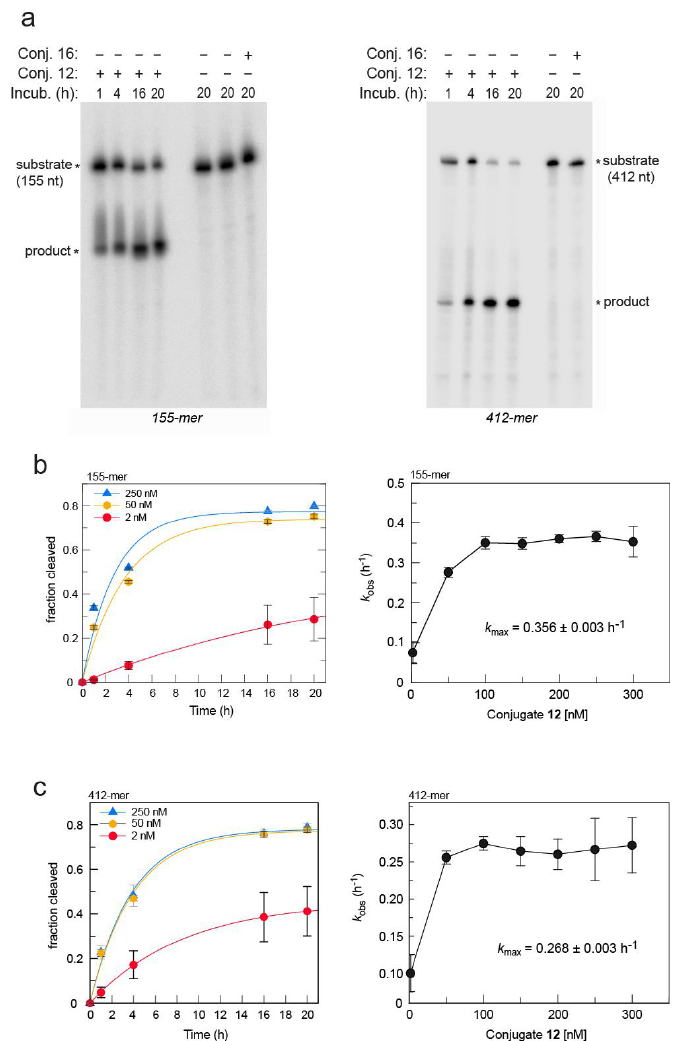
Figure 4. ( a ) Example gel images showing the time courses of cleavage of the RNA 155-mer 14 (left) and 412-mer 15 (right) by conjugate 12 at 37 °C. The 5′- 32 P-labeled 155-mer 14 and 412-mer 15 (~24 nM) were incubated with 300 nM (155-mer) and 200 nM (412-mer) of conjugate 12 for the indicated time periods. As a control, the RNA was incubated without conjugate or with the noncomplementary control conjugate 16 (cleaver-linker-5’-ctCcTgAcAaGgTat-3’; small letters: DNA; capital letters: LNA) for 20 h. ( b ) Examples of time courses (left image) of cleavage of the 155-mer 14 at three different concentrations of conjugate 12 , based on experiments, as shown in panel ( a ). Graph on the right: Plot of observed cleavage rate constant ( k obs ) as a function of conjugate 12 concentration (error bars: Standard deviation of the mean). Data points were connected by lines (no curve fitting), and the mean value of the k obs values obtained at 100 to 300 nM of conjugate 12 were used to derive k max . ( c ) As in ( b ), but using the 412-mer substrate RNA 15